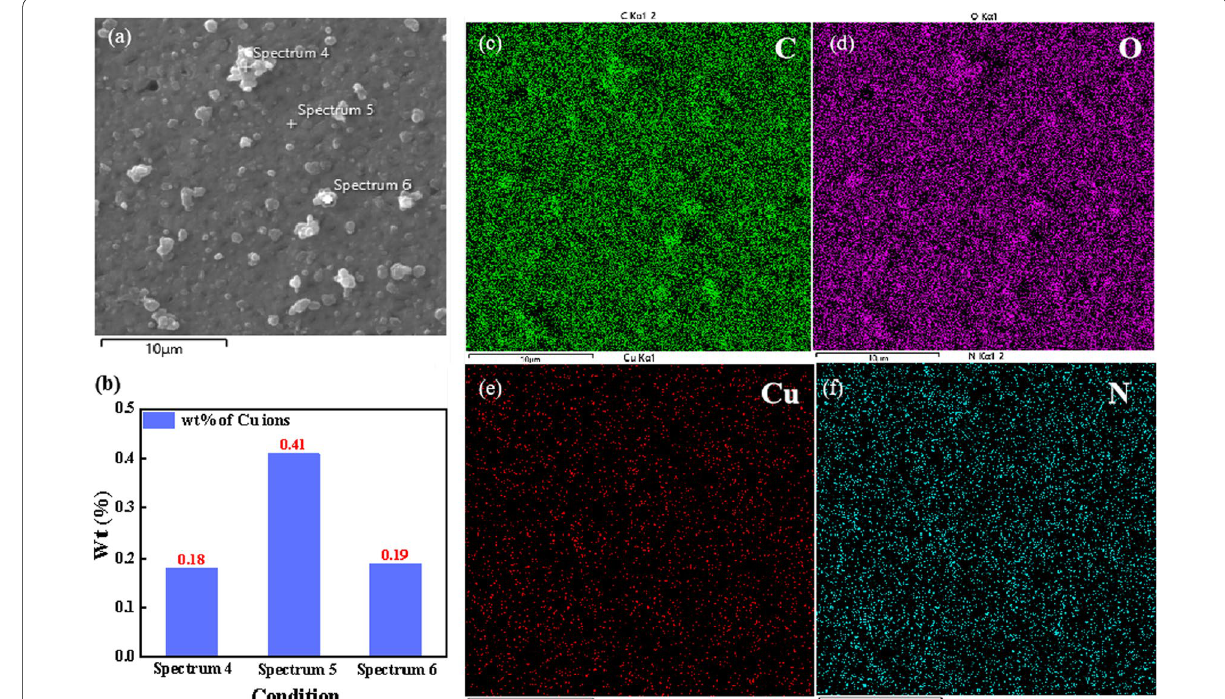
Fig. 4 a SEM images of PANI-2 porous film, b copper ions content of the above area, EDS elemental mapping images of the: c C element, d O element, e Cu element, f N